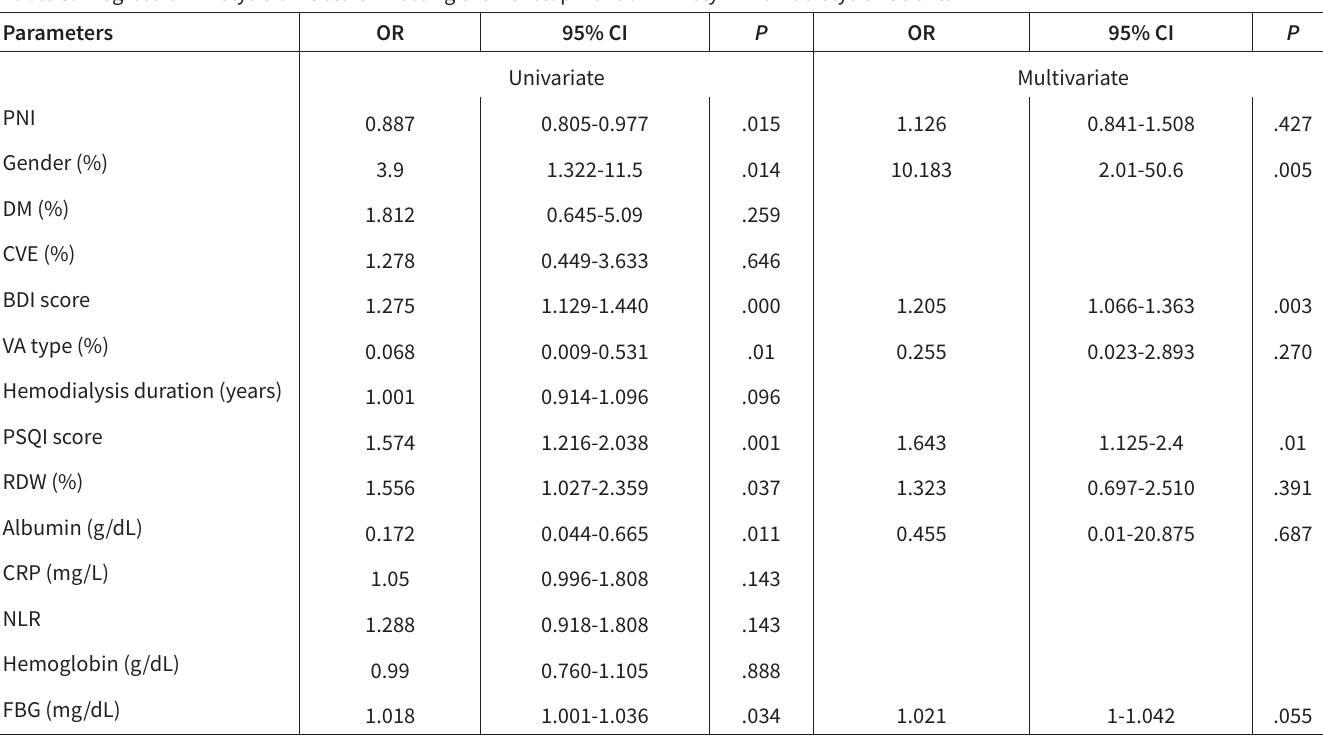
Table 3. Regression Analysis of Factors Affecting the Development of Anxiety in Hemodialysis Patients